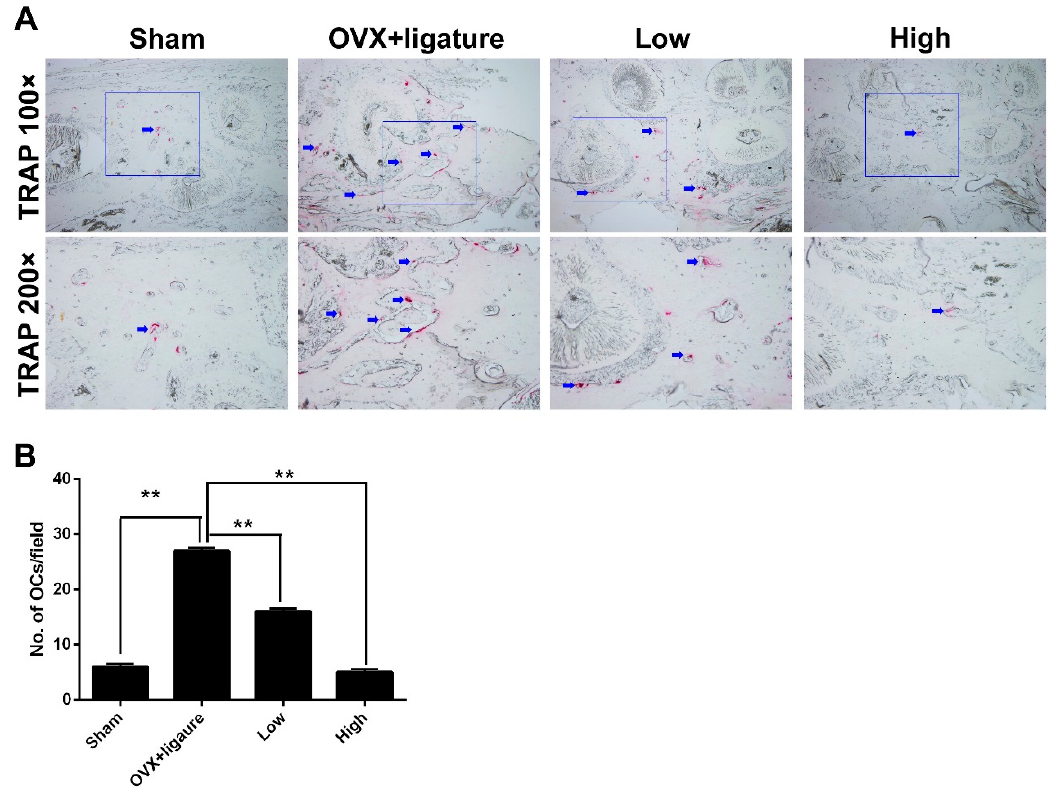
Figure 4. Analysis of tartrate-resistant acid phosphatase (TRAP) staining: ( A ) 100× and 200× magnified images of alveolar bone after TRAP staining and osteoclasts are stained red (blue arrows); and ( B ) number of osteoclasts per field of tissue (No. of OCs/field) in 200× magnification were analyzed; ** p < 0.017 between groups ( n = 6).